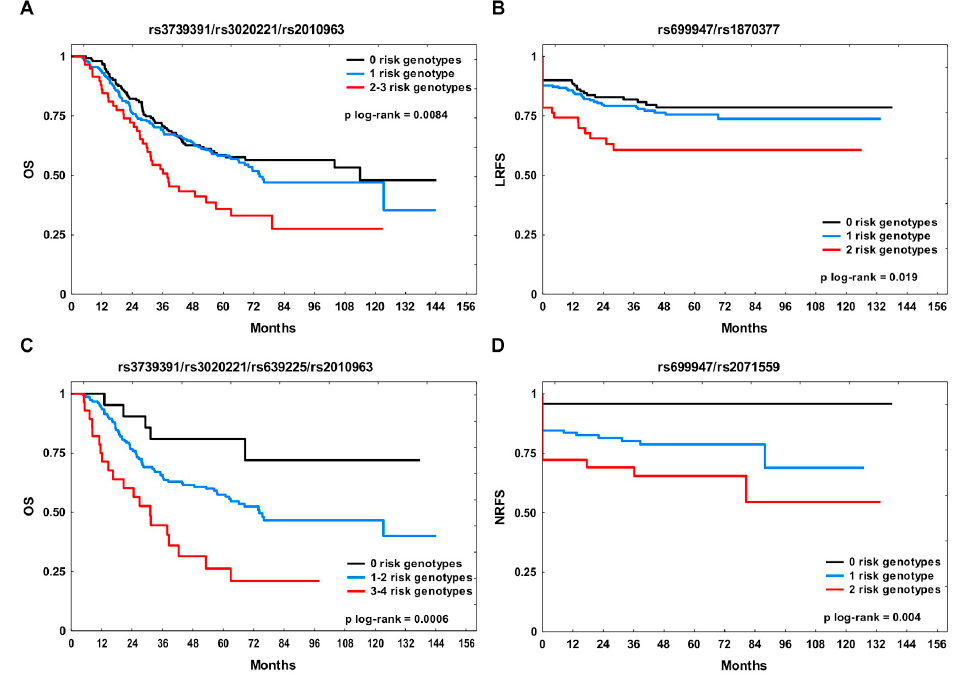
Figure 1. The Kaplan–Meier plots according to the number of risk genotypes for the studied endpoint. ( A ) Overall survival (OS) and ( B ) local recurrence-free survival (LRFS) in the whole study group; ( C ) OS and ( D ) nodal recurrence-free survival (NRFS) in the combination treatment subgroup (RT + CHT).